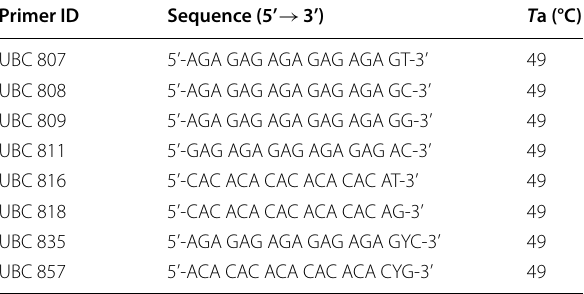
Ta annealing temperature